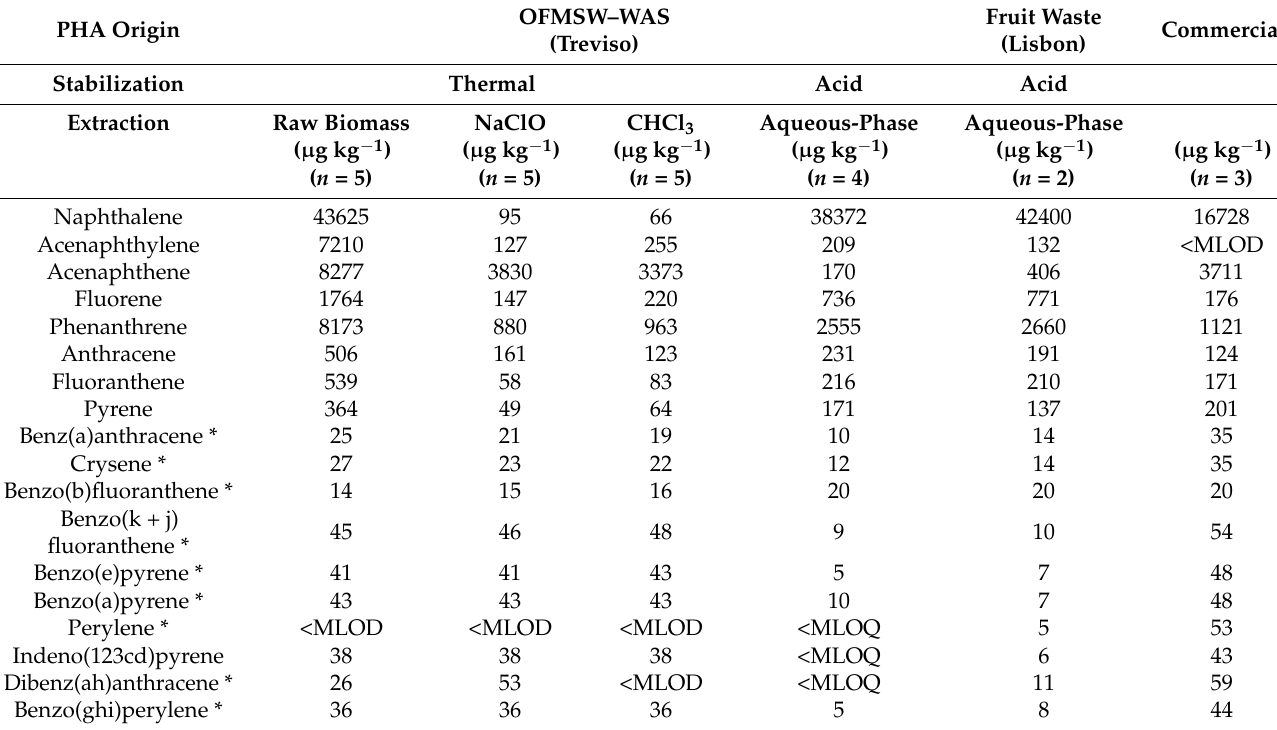
Fruit Waste (Lisbon)